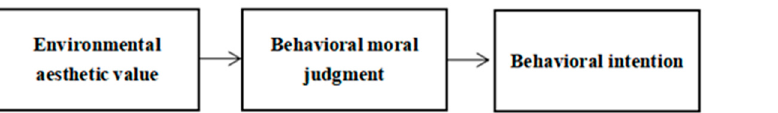
Figure 1. The path showing the influence of environmental aesthetic value on behavioral inten- tion.